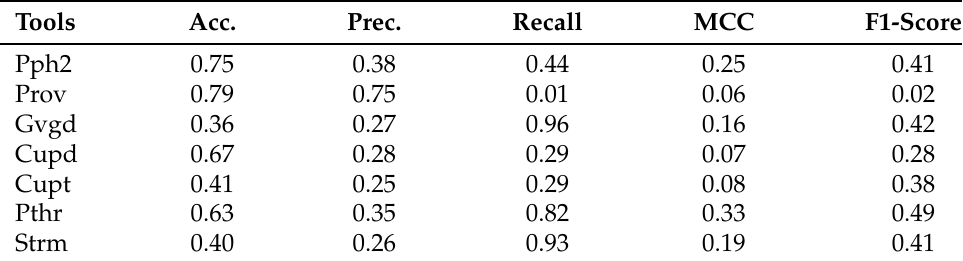
Table A1. The outer consistency results for the BRCA1-SGE dataset.